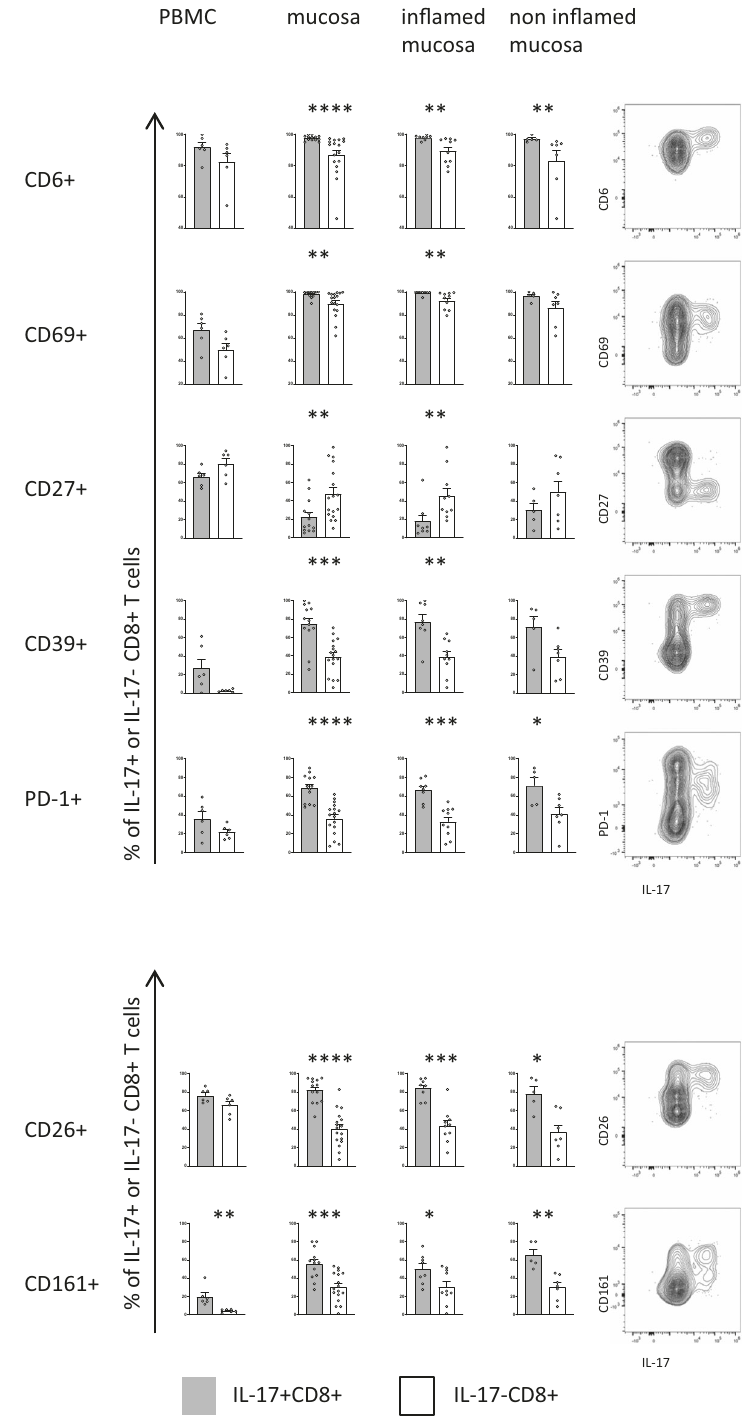
Fig. 3 Flow cytometric validation of the Tc17 signature in an independent cohort of CD patients. The expression of phenotypic IL-17 signature markers in CD8 + T cells after PMA/ionomycin stimulation was compared between IL-17 producing (grey) and non-IL-17 producing CD8 + T cells (white) from peripheral blood ( n = 6) and intestinal mucosa ( n = 17) and analyzed based on endoscopic in fl ammation: in fl amed mucosa ( n = 10) and non-in fl amed mucosa ( n = 7). (Right) Representative FACS plots of signature markers versus IL-17 production by CD8 + T cells isolated from an in fl amed mucosal sample of a CD patient. Data are presented as mean + / − SEM. Statistical tests used were two-sided. **** p < 0.0001, *** p < 0.001, ** p < 0.01, * p < While the reduction of γδ CD8 + T cells in the intestine and their and conventional CD8 + T cells, we stained speci fi cally for this infrequent IL-17 production were unexpected, these results could iNKT cell population using 6B11 monoclonal antibody 34 . As expected, these iNKT cells showed variable CD56 expression point to an ef fl ux of γδ T cells from the intestine into the per- (Fig. 4D). In comparison to other types of IL-17-producing ipheral blood but also to an accumulation of polarized pro- CD8 + T cells, frequencies of iNKTs were negligible (Fig. 4E). in fl ammatory conventional T cells at the site of in fl ammation. A